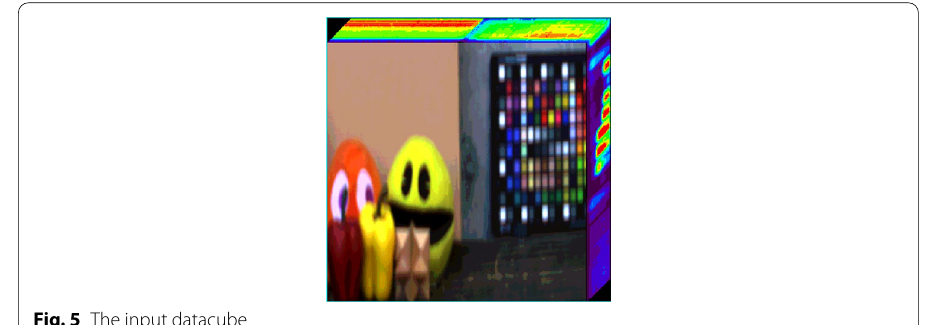
Fig. 5 The input datacube